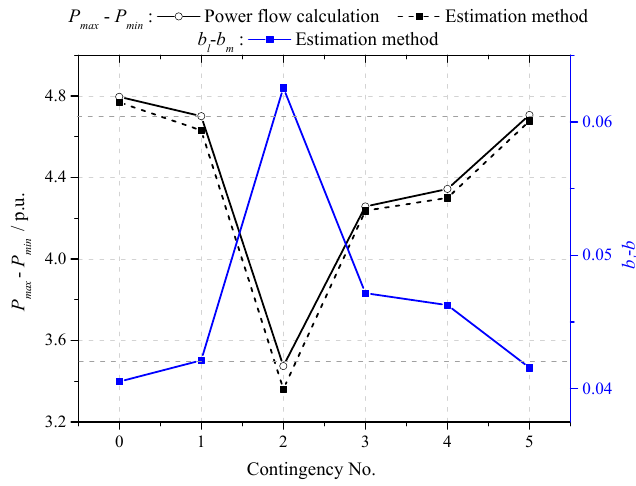
Figure 13. b l - b m and the range of P m under different contingencies.